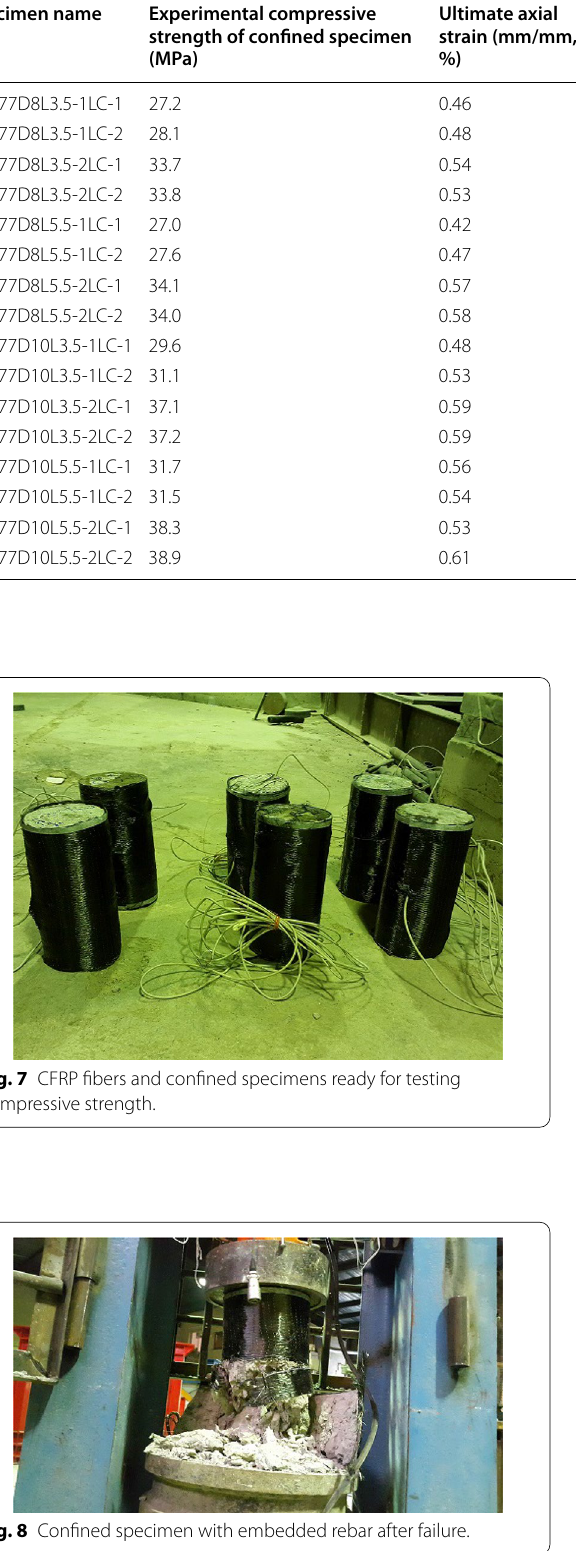
Table 8 Compressive strength of each specimen confined with CFRP fibers.